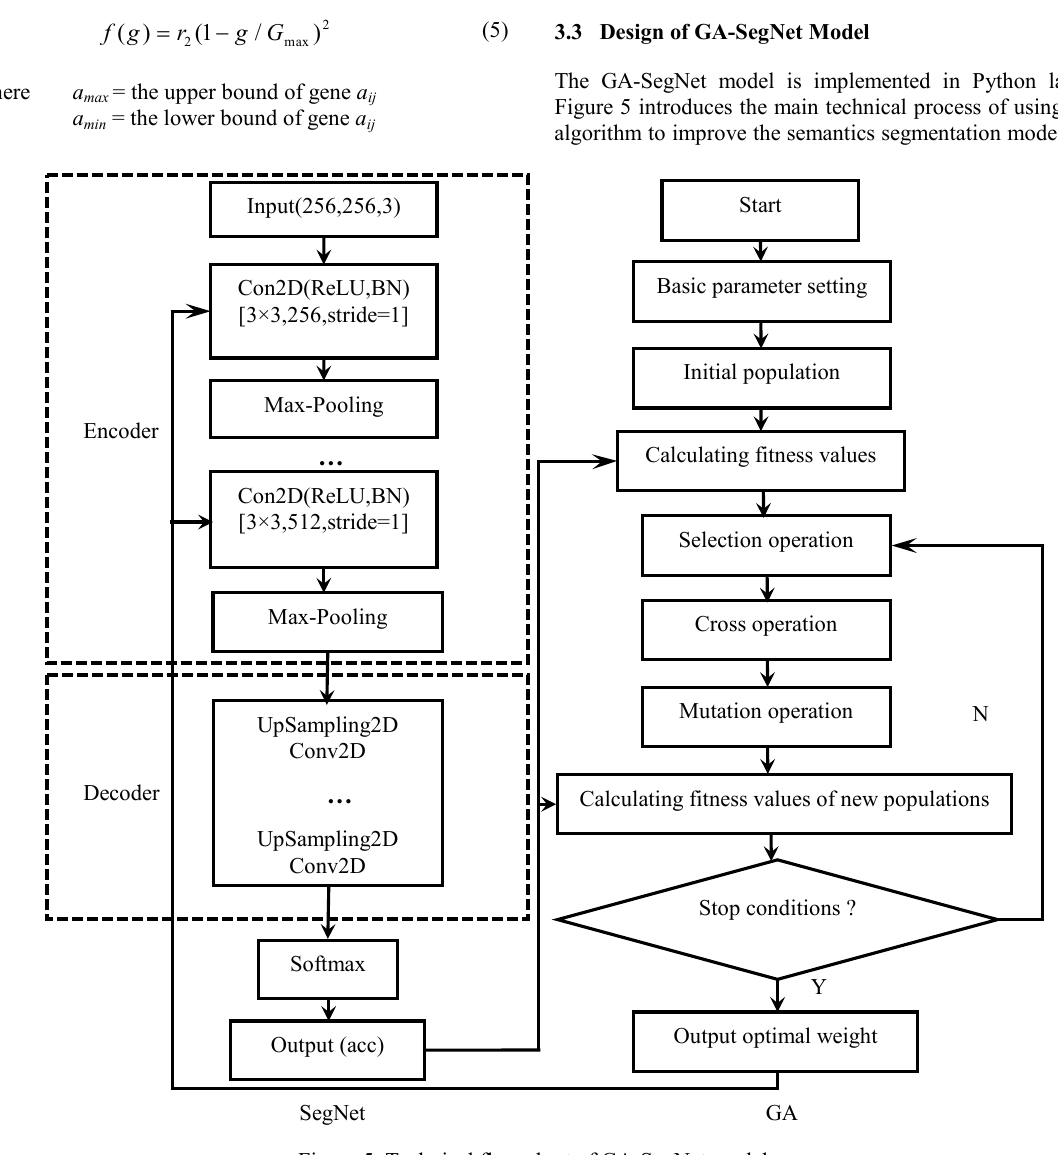
Figure 5. Technical flow chart of GA-SegNet